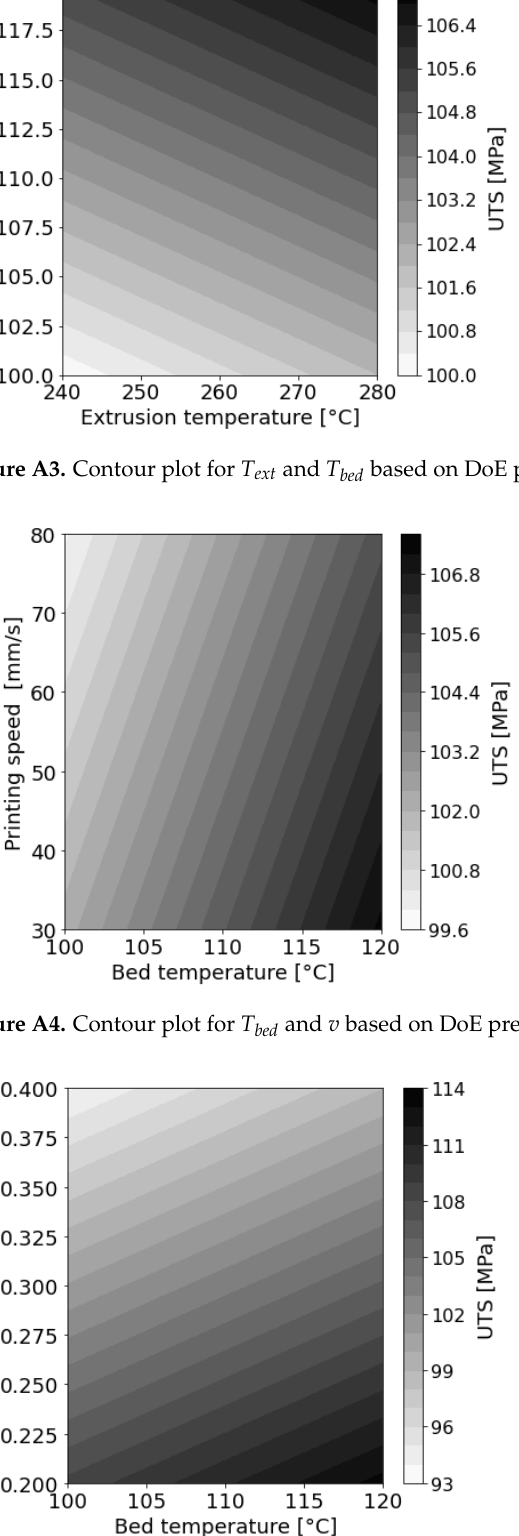
Figure A5. Contour plot for T bed and h based on DoE prediction model.